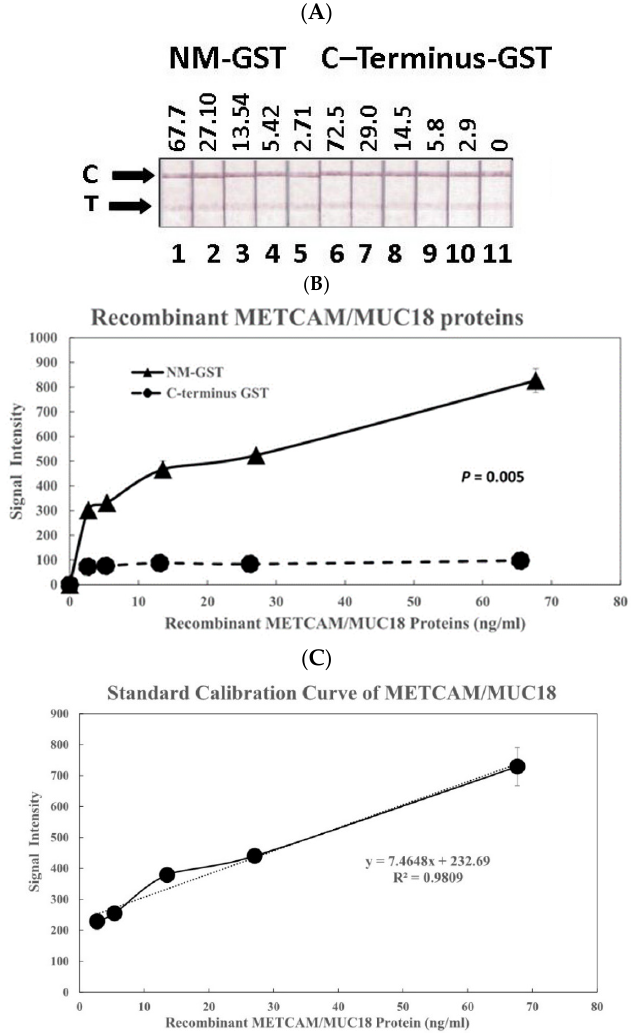
Figure 2. ( A ) Recombinant std protein image combo1, ( B ) Positive and negative controls combo1, ( C ) Calibration curve combo 1. Establish the calibration curve from recombinant huMETCAM/MUC18 proteins as determined by a modified LFIA method using the combination of biotinylated rabbit antibody (EPP11278) and nanogold-conjugated home-made chicken antibody. ( A ) shows the inten- sities of the two recombinant METCAM/MUC18 proteins, the positive control protein, NM-GST (N-terminus and the middle portions fused to GST), and the negative control protein, C-terminus-GST (the C-terminus portion fused to GST), at different concentrations. C stands for control lines and T for test lines. ( B ) shows the quantitative results of the intensities of the two recombinant MET- CAM/MUC18 proteins at different concentrations. ( C ) shows the standard calibration curve obtained by subtracting the intensity of the negative control protein from the positive control